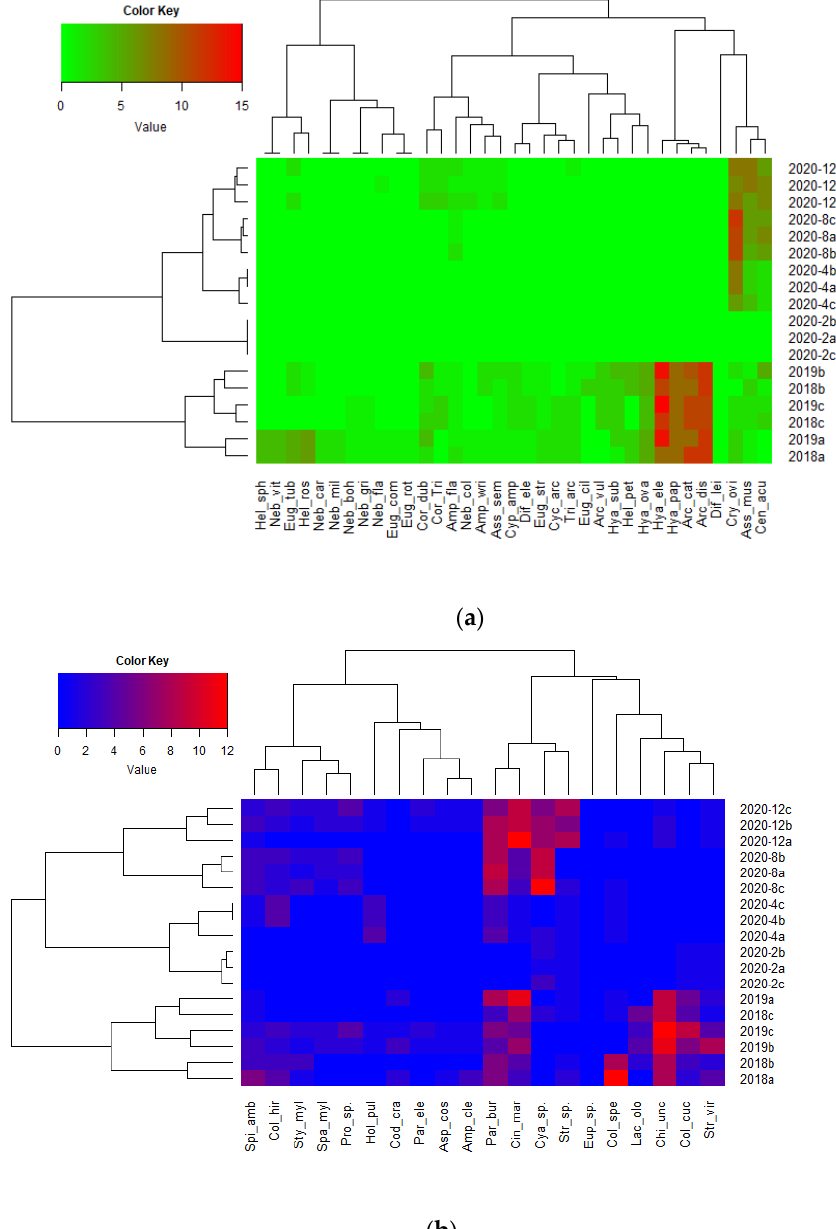
Figure 5. Dendrogram and heatmap of hierarchical cluster analysis of species composition of ( a ) testate amoebae and ( b ) ciliates based on Brey’s coefficient and Ward method. The letters a, b, c (right edge of the graph) indicate the number of the measurement during the period.